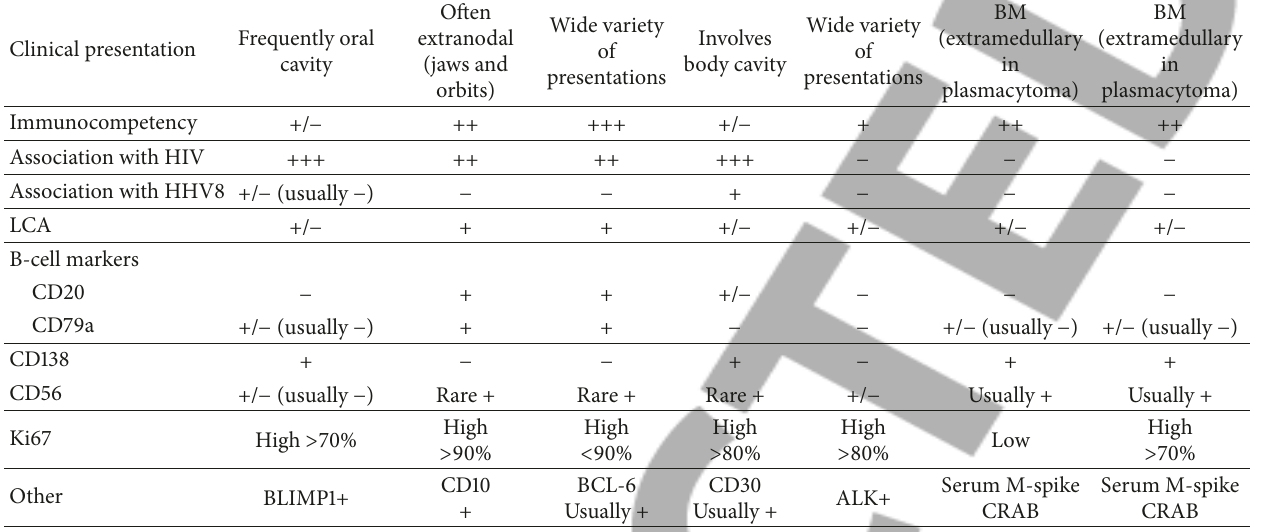
Table 1: The main differential diagnosis of